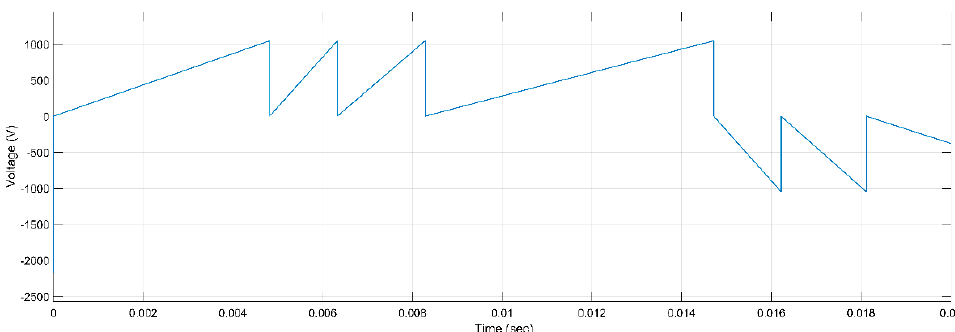
Figure 30. PD Activity for Combination, 10 kV, h, 2 r.